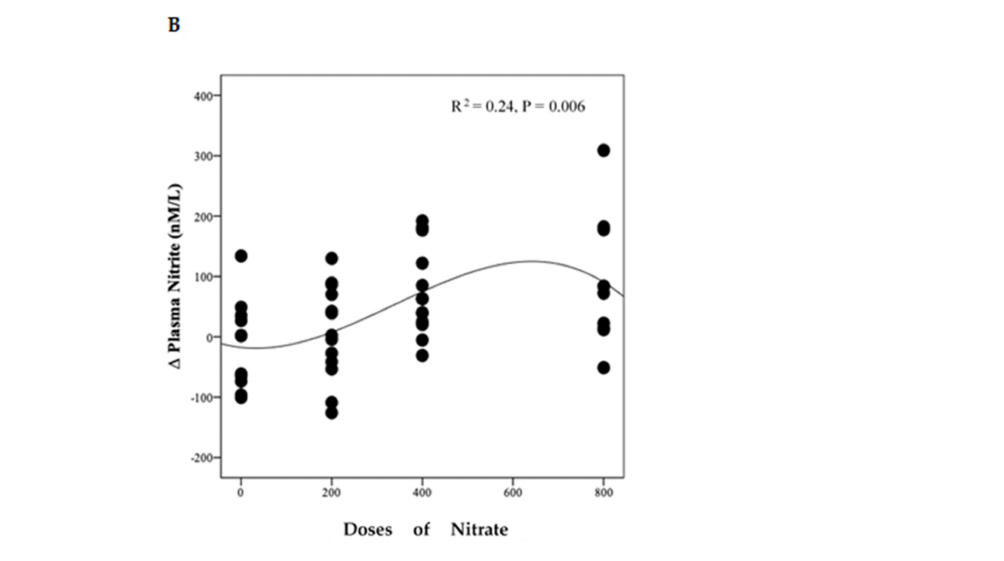
Figure 4. Relationship between changes in plasma NO 3 − , NO 2 − and doses of NO 3 − . This figure shows the relationship between changes in plasma NO 3 − ( A ) and NO 2 − ( B ) and doses of NO 3 . Regression lines are fitted to each distribution, ( A ) is linear and ( B ) is cubic, ( n = 49).